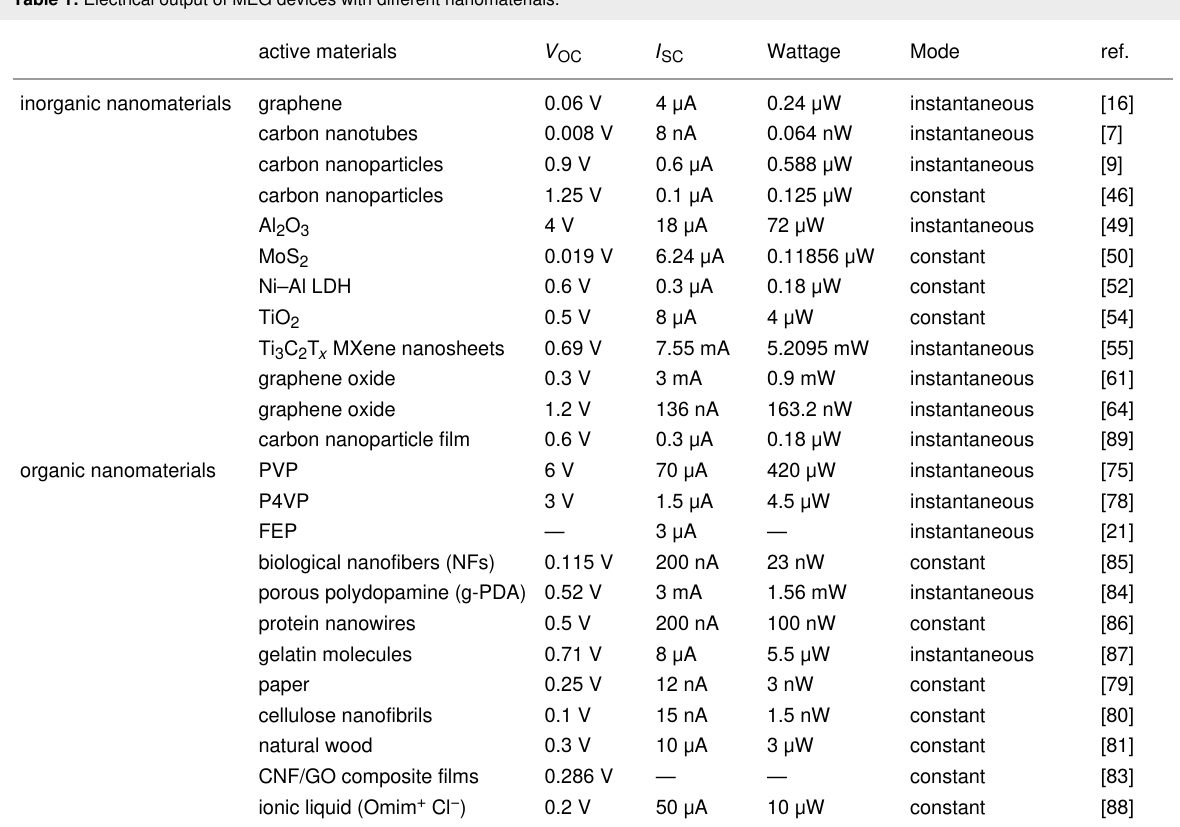
Table 1: Electrical output of MEG devices with different nanomaterials.